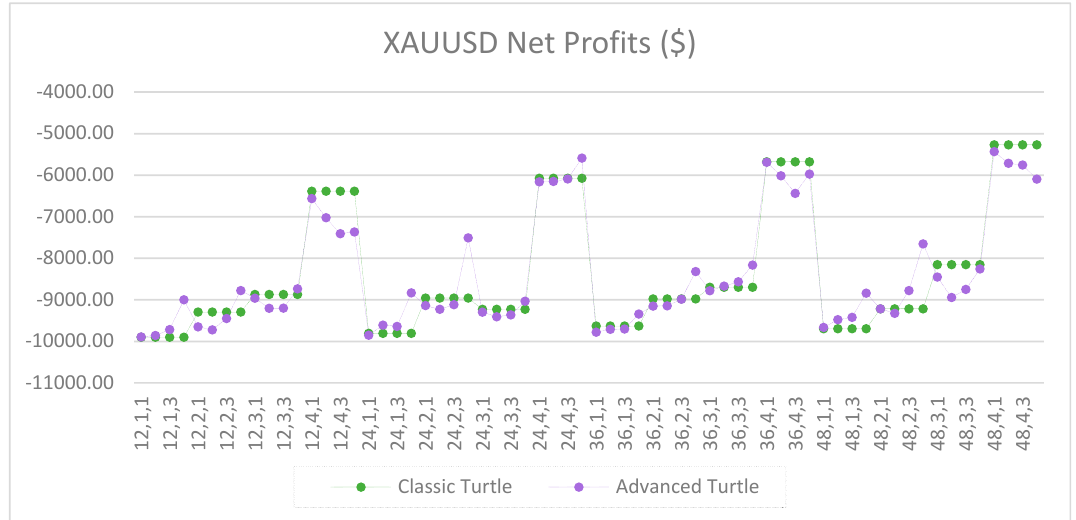
Figure A27. Net profits of XAUUSD between the classic and the advanced Turtle systems for every combination of N, X, Y for the medium parameters (40, 80).